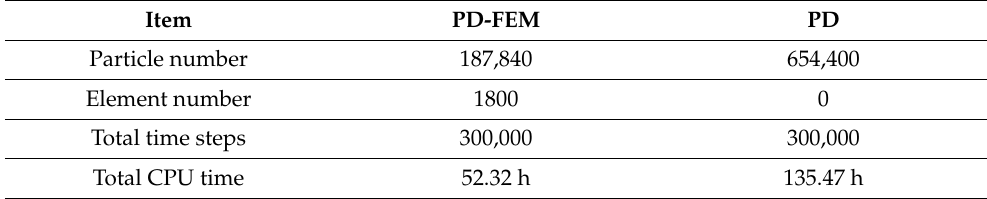
Table 4. Comparison of PD and PD-FEM coupling approach in computational